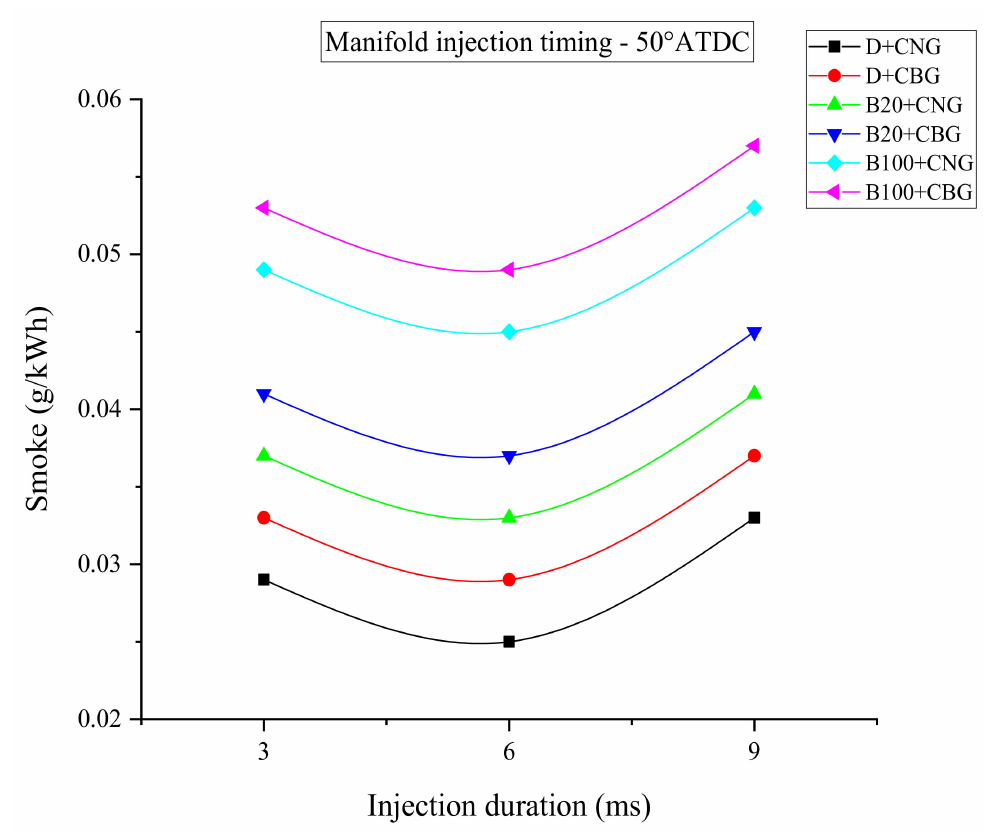
Figure 13. Variation of Smoke emissions with